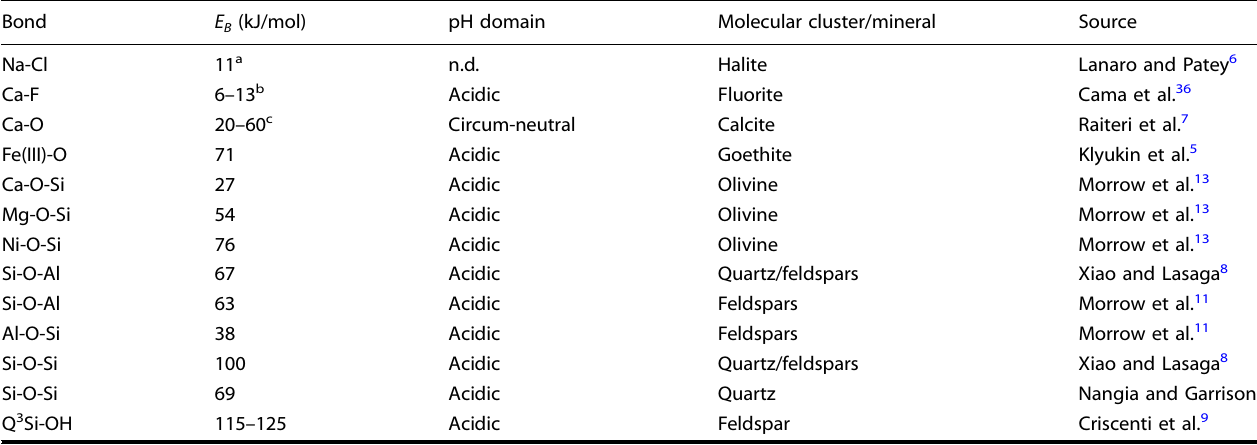
Table 1. Theoretical bond-breaking activation energies of bonds encountered in common